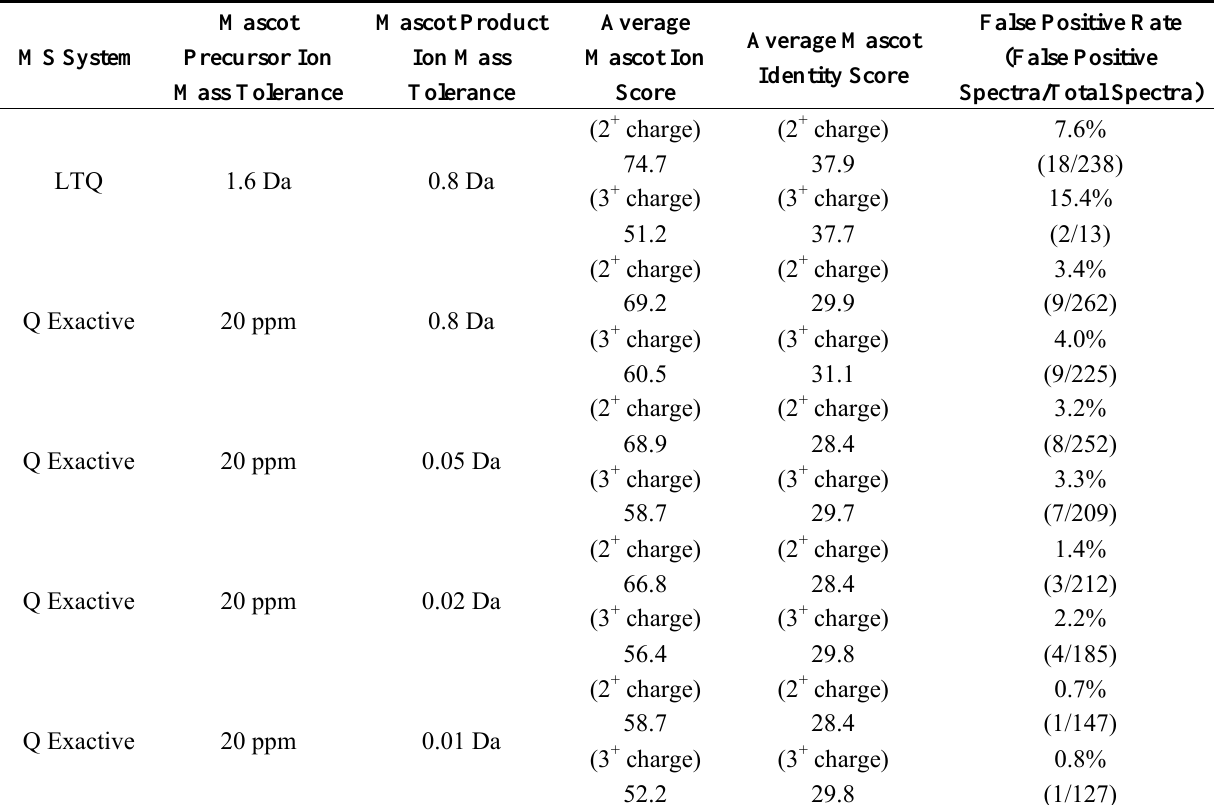
Table 1. False positive identifications of deamidated sites using various Mascot searching